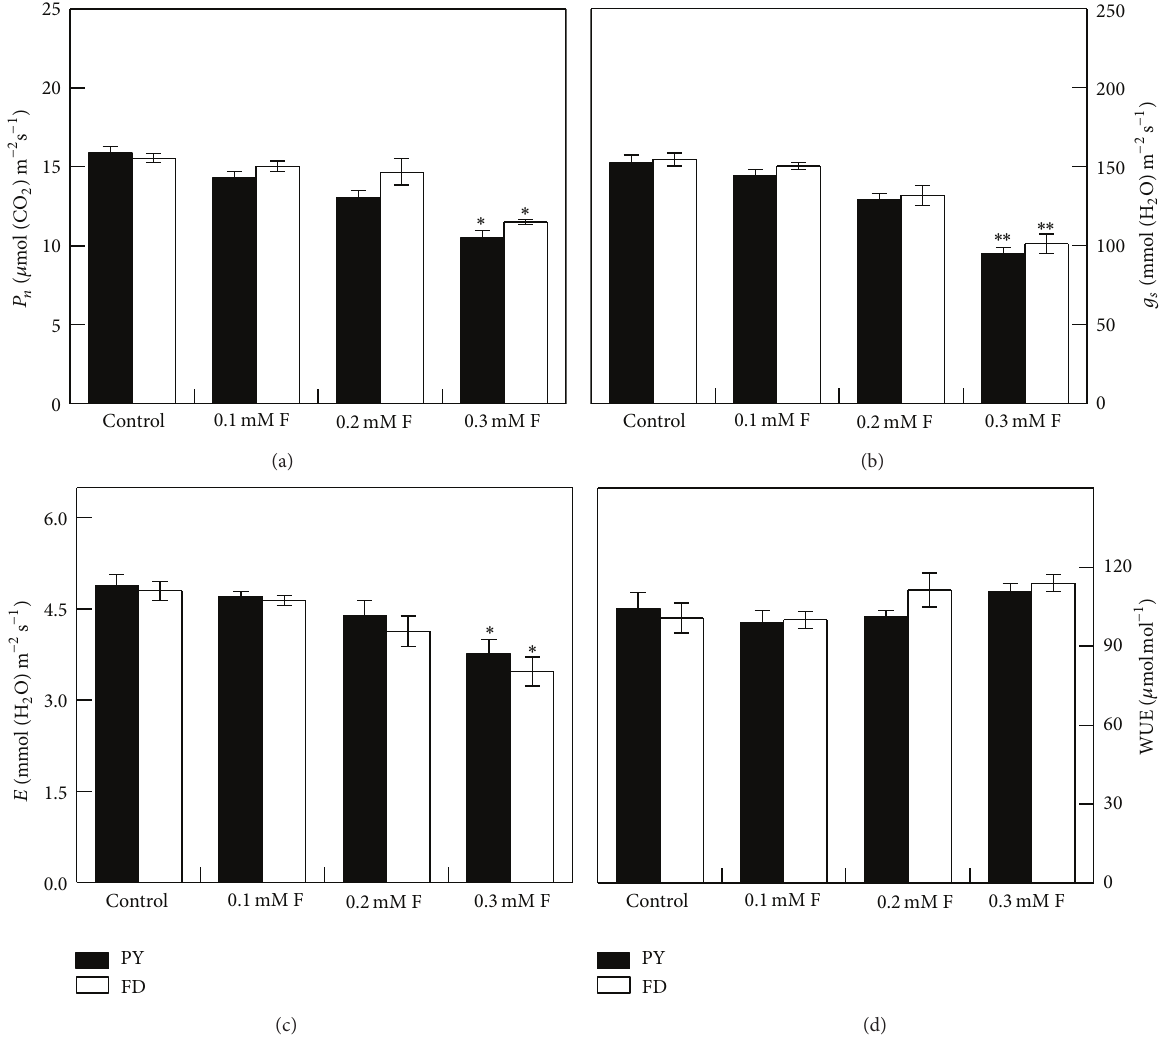
Figure 1: (a) Net photosynthetic rate ( 𝑃 𝑛 ); (b) stomatal conductance ( 𝑔 𝑠 ); (c) leaf transpiration ( E ); and (d) water use efficiency (WUE) after 2 weeks of treatments. Data are expressed as mean ± SD ( 𝑛 = 4 ). PY: “Pingyangtezao” tea cultivar; FD: “Fudingdabai” tea cultivar. ∗ ( ∗∗ ) indicates significant difference compared with the control at 𝑃 < 0.05 ( 𝑃 < 0.01 ) according to Fisher’s 𝐹